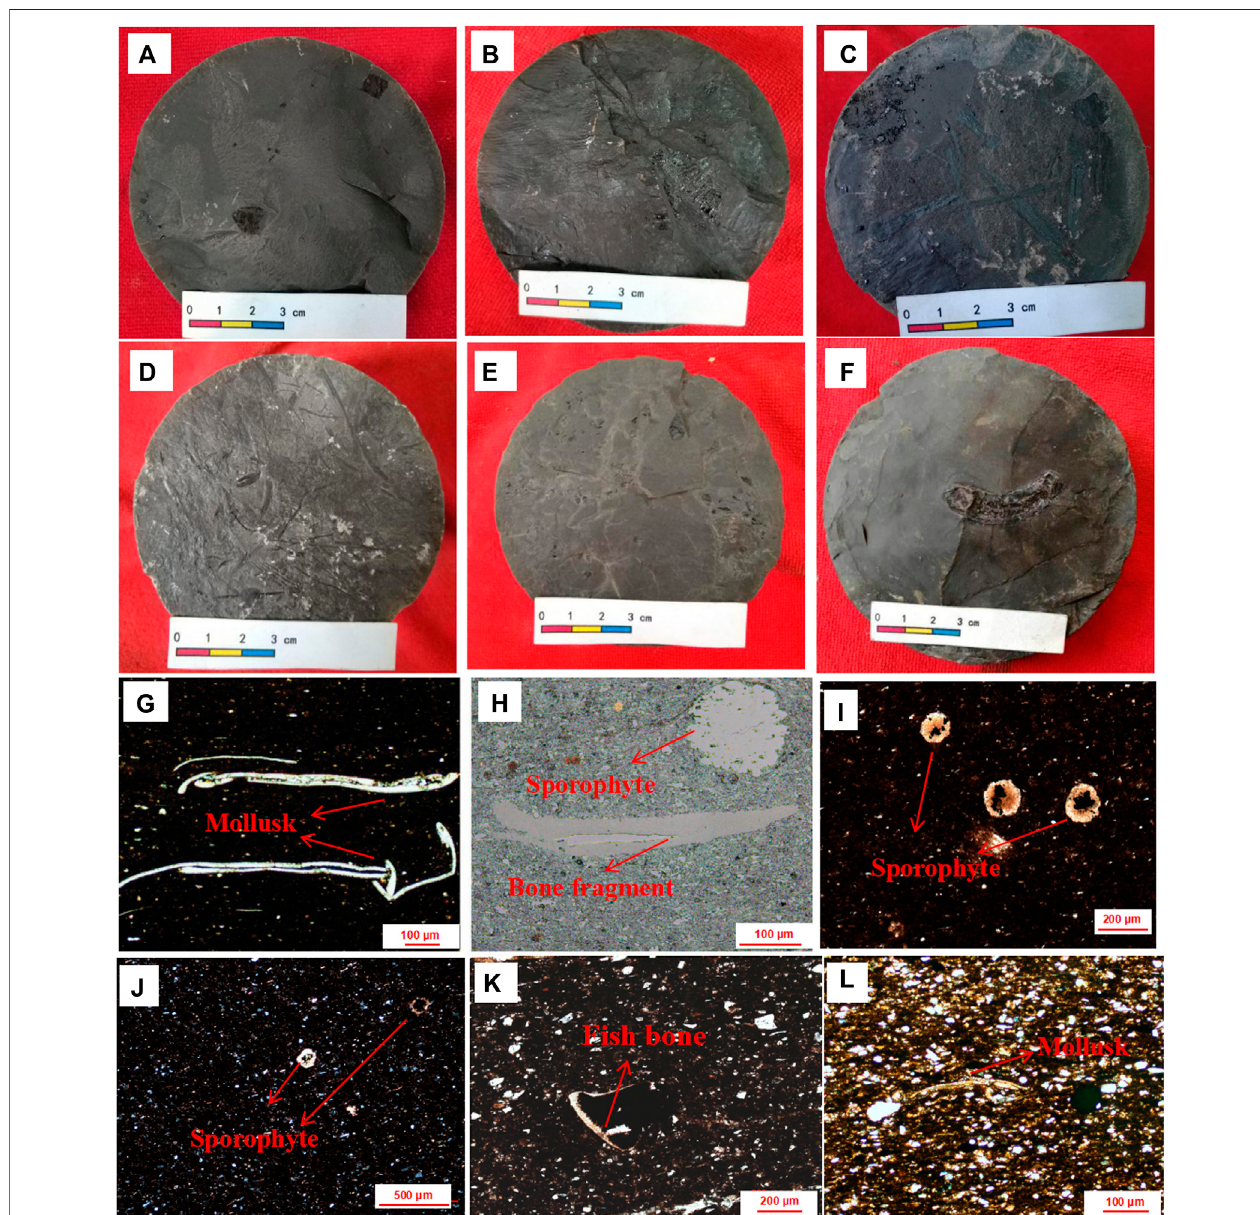
FIGURE 6 | Core and microscopic characteristics of source input (A) core photo showing plant debris (fossils), Z22 well, 1223.91 m; (B) core photo showing abandant plant debris (fossils) and carbonized particles, S31 well, 1152.35 m; (C) core photo showing abandant plant debris (fossils) and carbonized particles, D19 well, 1369.91 m; (D) core photo showing abandant plant debris (fossils), Q208 well, 1080.89 m; (E) core photo showing a large number of fi sh scales (fossils), Q100 well, 1383.07 m; (F) core photo showing an intact fi sh (fossils), S31-14 well, 141.16 m; (G) cast thin section, Plane-polarized light (10X) showing thin walled calcitic skeletal fragments, possible mollusks. YY1 well, 1315.12 m; (H) cast thin section, right- fi eld re fl ected light (10X) showing bone fragment (center) and possible spore (upper right), YY1 well, 1374.24 m; (I) cast thin section, single polarization (10X) showing a black shale with sporophyte, YCCV1245 well, 1555.6 m; (J) cast thin section, single polarization (5X) showing a black shale with sporophyte, D11 well, 1762.08 m; (K) cast thin section, single polarization (10X) showing a sandy laminated shale with fossilized fi sh bone, YCCV1245 well, 1562.63 m; (L) cast thin section, single polarization (10X) showing a thin walled calcitic skeletal fragments, possible mollusk, YY1 well, 1397.66 m.